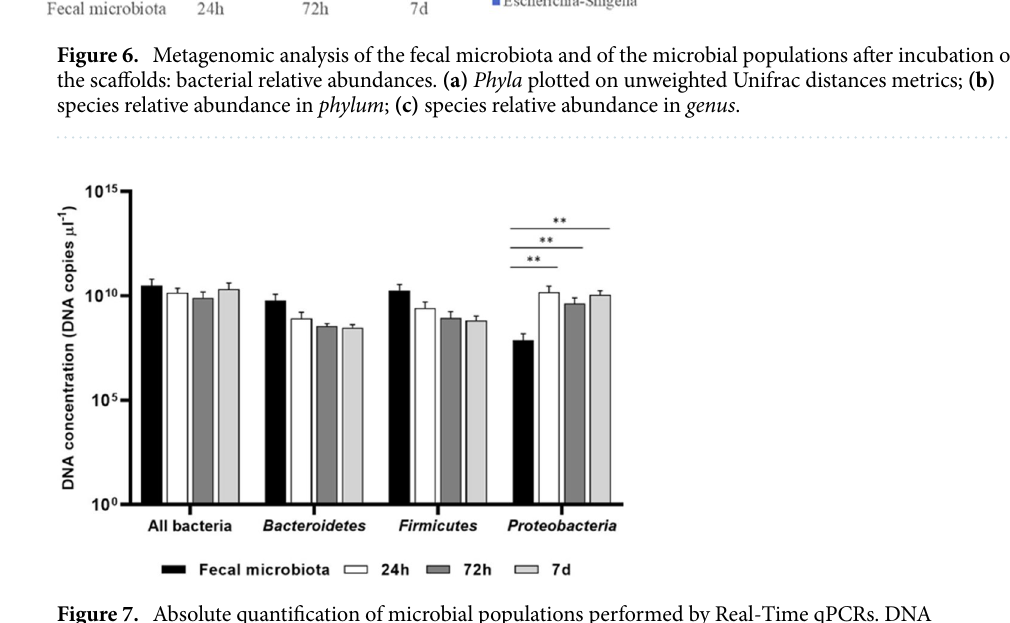
Figure 7. Absolute quantification of microbial populations performed by Real-Time qPCRs. DNA concentration (DNA copies µl -1 ) relative to the 16S rRNA gene for total bacterial load (all bacteria), Bacteroidetes , Firmicutes , and Proteobacteria in fecal microbiota (black bars) and in vitro-cultured microbiota at 24 h (white bars), 72 h (grey bars), and 7 d (light grey bars). ** p <